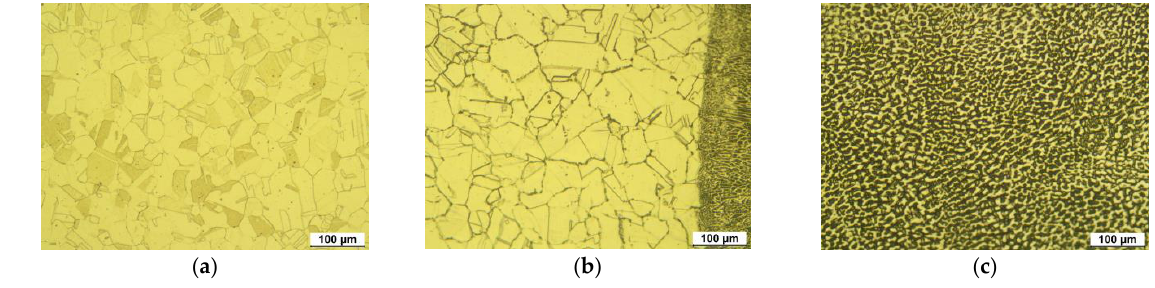
Figure 3. Optical microstructure of 304L stainless steel before LP (OM, ×200, 10% oxalic acid); ( a ) 304LB (base metal), ( b ) 304LW-H (HAZ), and ( c ) 304LW-W (weldment). Figure 4 shows the surface appearance (digital camera photo, SEM, and 3D microscopy)